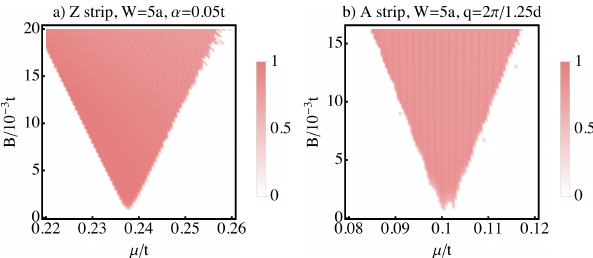
Figure 14: Dependence of the MP with B and µ for a strip with W = 5 a , L = 1557 a , ∆ = 0.001 t for a) a Z strip with α = 0.05 t . Note the formation of Majoranas for a region centered around µ = 0.23 − 0.24 t , for B > 0.001 t b) an A strip with q = 5 ≈ 2 π/ ( 1.25 d )